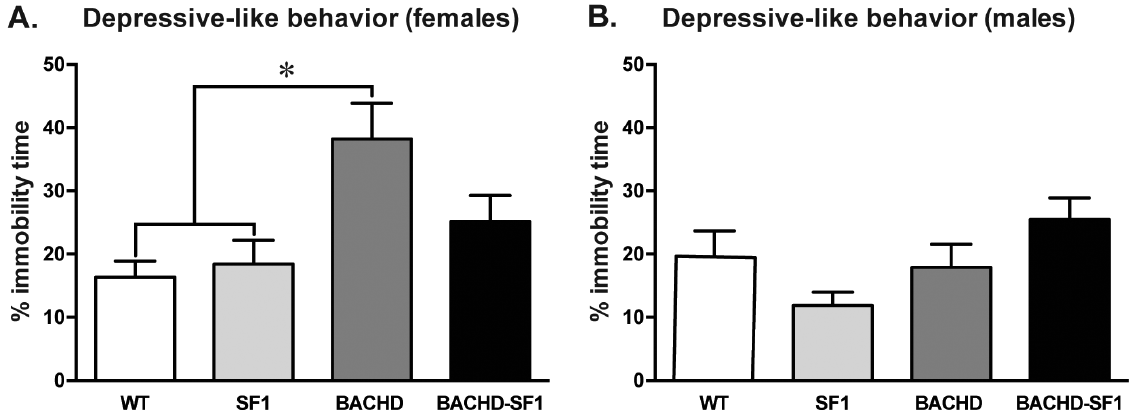
Figure 6. Evaluation of the depressive-like behaviors in BACHD-SF1 mice. Depressive-like behaviors were assessed using the forced swim test (FST) whereby the percentage of time spent immobile was recorded. A. In females, the percentage of time spent immobile was significantly higher in BACHD mice compared to the control groups whereas the result for BACHD-SF1 mice was not significant to any groups, suggesting a partial positive effect of inactivation of mutant HTT in SF1 neurons on this behavior. B. There were no differences in the percentage of time spent immobile across all genotypes in males. Data presented as mean 6 SEM (* p , 0.05, one-way ANOVA with Tukey multiple comparisons post-hoc test), n=11–28/ genotype/sex in each group. Detailed statistical analyses are outlined in Figure 6 of Statistical Results S1.